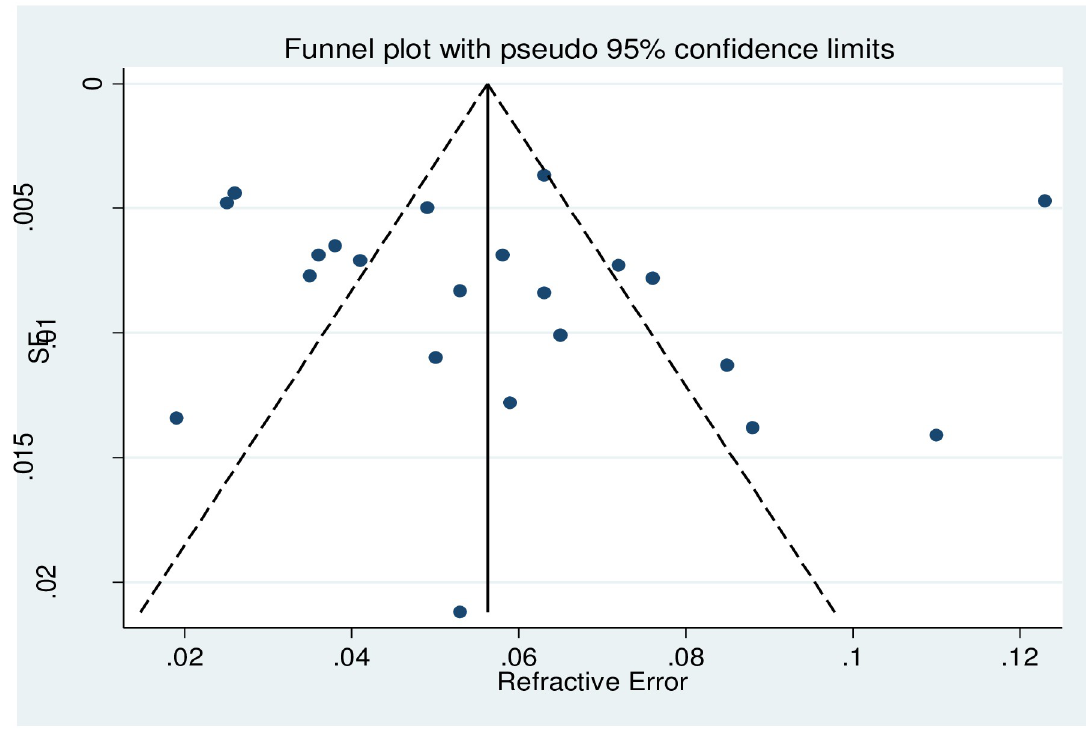
Fig 2. Showing the publication bias status of studies included for meta-analysis on visual impairment due to refractive error in Ethiopia,2021.